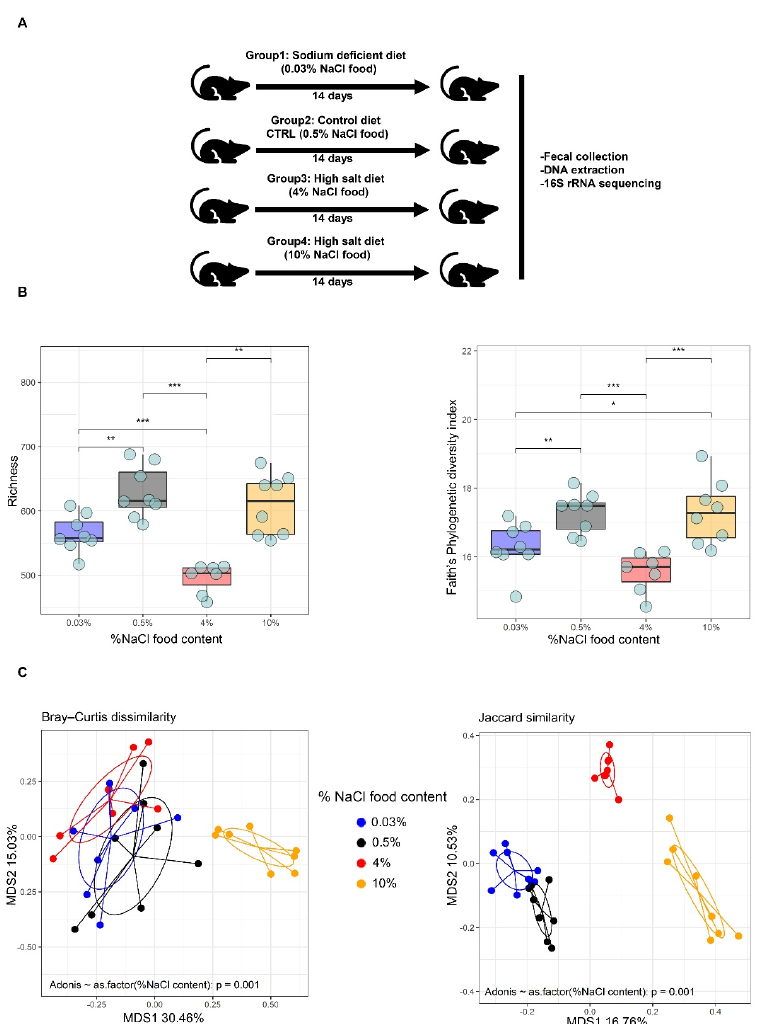
Figure 1. Impact of salt on the composition and structure of the murine gut microbiome. ( A ) Exper ‐ imental design. C57BL/6 male mice were fed on sodium ‐ deficient 0.03% NaCl, 0.5% NaCl (control), high salt 4% NaCl (HSD) and high salt 10% NaCl (HSD), then the bacterial composition of the mouse gut was profiled using the 16S rRNA amplicon sequencing. ( B ) Alpha diversity analysis of fecal microbiota, richness (left) and Faith’s phylogenetic diversity (PD) (right). ( C ) Principal coordinate analysis plot of beta diversity measure Bray ‐ Curtis dissimilarity (left), PCoA based on Jaccard’s sim ‐ ilarity calculated from the presence/absence of taxa represented on the 16S rRNA gene (right). * p ≤ 0.05—; ** p ≤ 0.01—; *** p ≤ 0.001. Similar to 4% NaCl ‐ fed mice, the community diversity decreased in the 0.03% NaCl group compared to the control group (0.5% NaCl). Although analyses using richness and Faith’s Phylogenetic diversity index indicated differences between bacterial communities